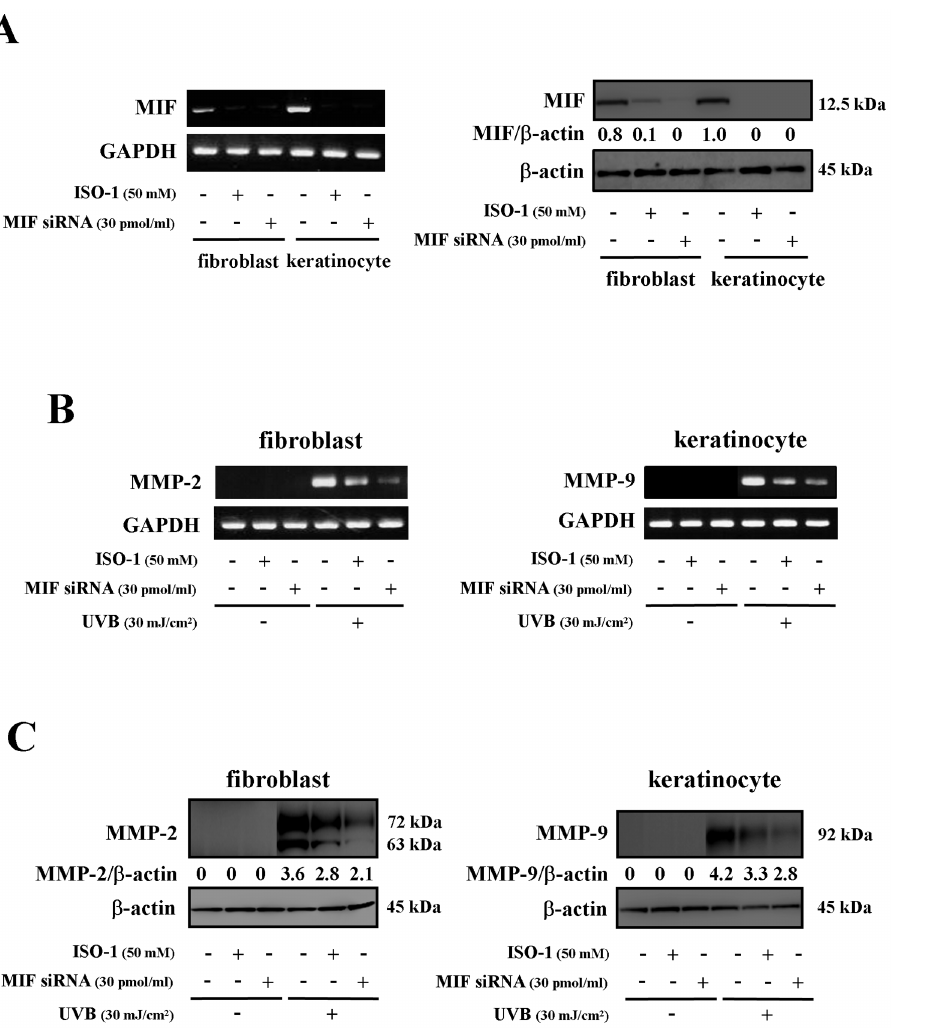
Figure 6. Effects of an MIF inhibitor (ISO-1) or MIF si RNA on the expression and production of MMP-9 and MMP-2 following UVB radiation. (A) The cells were treated with ISO-1 at 50 m M for 24 hours or MIF siRNA (30 pmol/ml) for 48 hours. Next, the expression of MIF mRNA and MIF protein was examined. (B) The expression levels of MMP-9 and MMP-2 mRNA were examined. Cells were pretreated with ISO-1 at 50 m M for 24 hours or MIF siRNA (30 pmol/ml) for 48 hours, and then were exposed to UVB light (30 mJ/cm 2 ). Total RNA was isolated six hours after UVB exposure and analyzed by RT-PCR. (C) Cells were pretreated with ISO-1 at 50 m M for 24 hours or MIF siRNA (30 pmol/ml) for 48 hours, and were then exposed to UVB light (30 mJ/cm 2 ). The Western blot analysis for the MMP-9 and MMP-2 proteins (30 m g of protein for each group) was performed 24 hours after UVB irradiation. The band of b -actin was used to normalize the expression level. A densitometric analysis was also performed to evaluate the intensity of each band. The data shown are representative of three independent